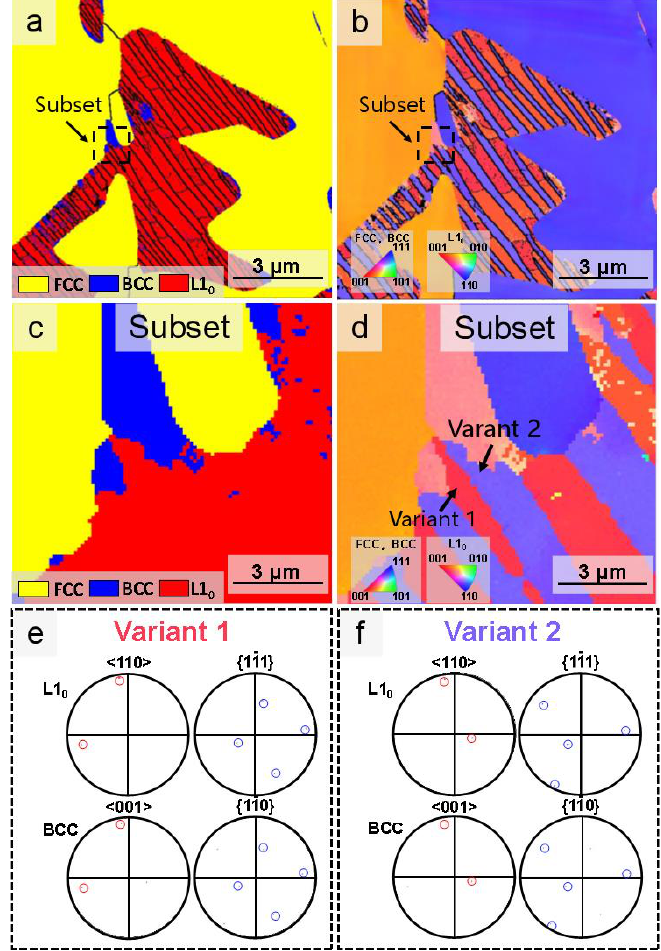
Figure 5. EBSD results of BCC regions with nano-scale lamellar structures at high magnification. ( a ) Phase map; ( b ) IPF map; ( c ) phase map of the subset; ( d ) IPF map of the subset; ( e ) pole figures of variant 1 and BCC austenite. The pole points on the (111) (blue circle) and [110] (red circle) pole figures of the L1 0 phase (Variant 1) overlap with those on the (1-10) (blue circle) and [001] (red circle) pole figures of the BCC austenite phase; ( f ) pole figures of variant 2 and BCC austenite. The pole points on the (111) (blue circle) and [110] (red circle) pole figures of the L1 0 phase (Variant 1) overlap with those on the (1-10) (blue circle) and [001] (red circle) pole figures of the BCC austenite phase, implying the preferred orientation relationship.